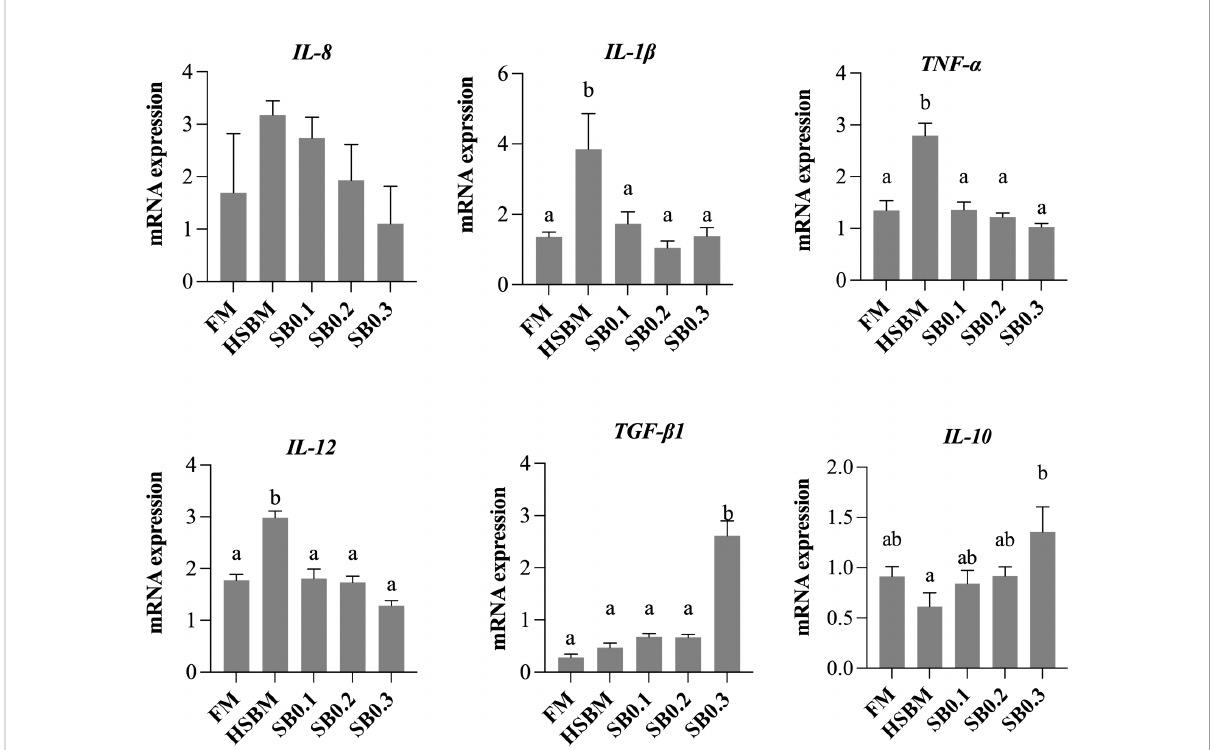
FIGURE 6 Effects of sodium butyrate (SB) addition in high soybean meal (SBM) diets on mRNA levels of intestinal in fl ammatory factor genes of groupers in a 56-d feeding period. Bars bearing the different letters indicate signi fi cant differences ( P < 0.05), while that with the same letters indicate no signi fi cant difference ( P > 0.05). Data are presented as means ± SEM (n = 3 tanks). Statistical analysis was performed by one-way ANOVA, followed by S-N-K test. FM, fi sh meal; HSBM, 60% FM protein replacement with SBM in FM diets without SB addition; SB0.1, SB0.2 and SB0.3, 0.1%, 0.2%, and 0.3% SB were added in the HSBM diets, respectively. IL-8 , interleukin-8; IL-1 b , interleukin-1 b ; TNF- a , tumor necrosis factor- alpha; IL-12 , interleukin-12; TGF- b 1, transforming growth factor-beta 1; IL-10,